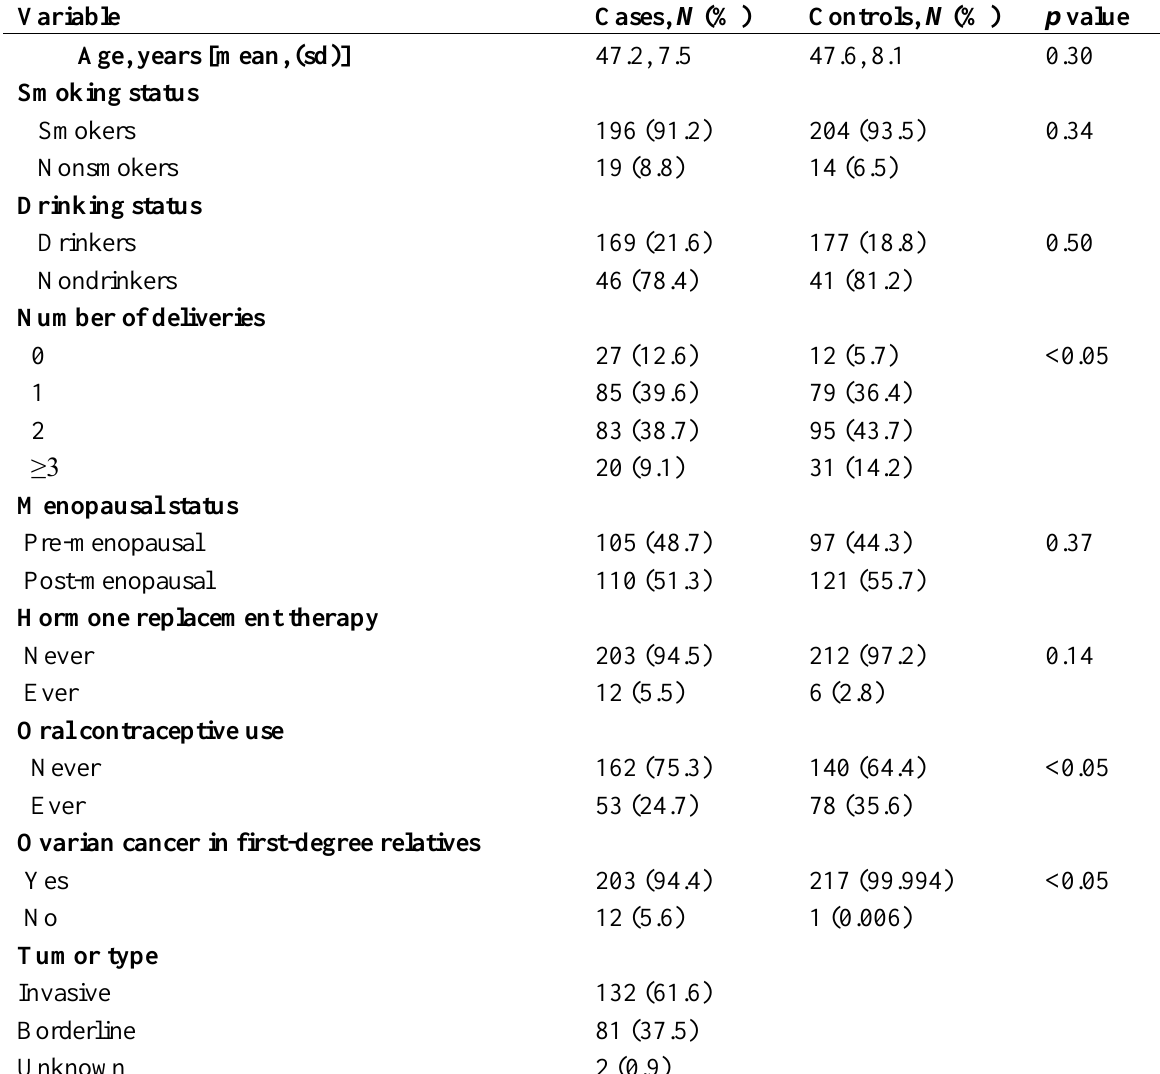
Table 1. Demographic and clinical characteristics of ovarian cancer